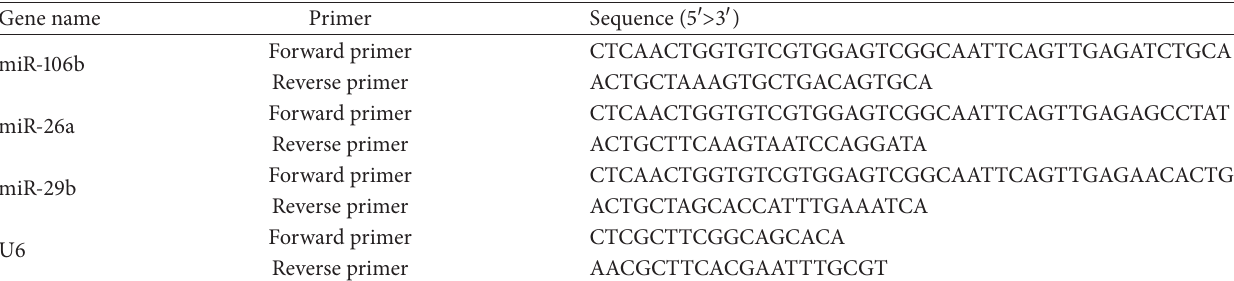
Table 2: Primer sequences for the real-time RT-PCR for miRNAs and U6.